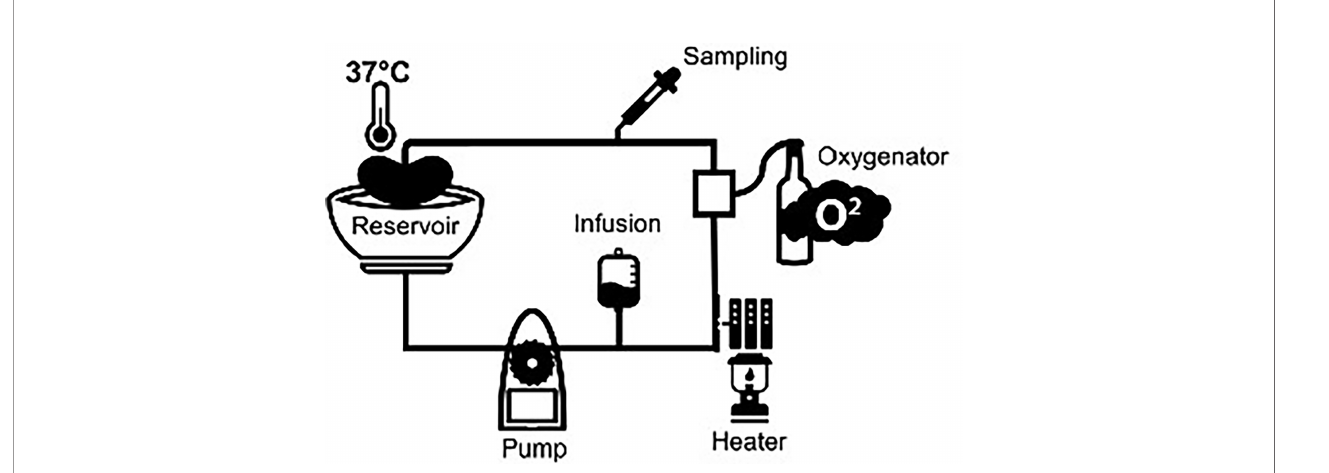
FIGURE 1 | Normothermic machine perfusion